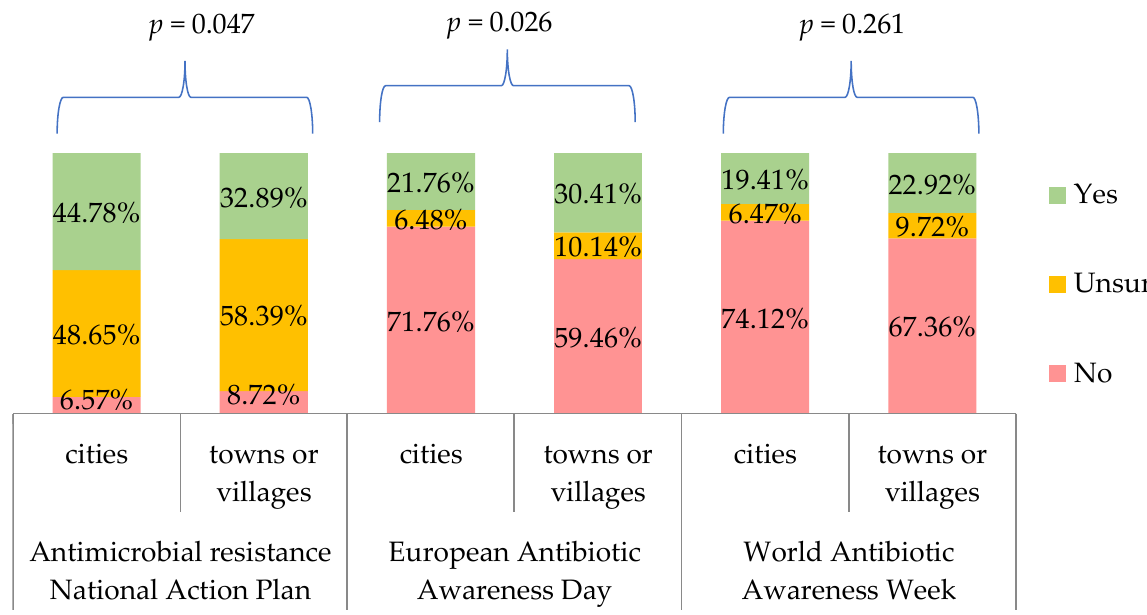
Figure 5. Percentage of respondents who were aware/unaware of whether their country had a national action plan on antimicrobial resistance, who had/had not heard of European Antibiotic Awareness Day, and who had/had not heard of World Antibiotic Awareness Week, by respondents’ place of residence. p for chi-square test.